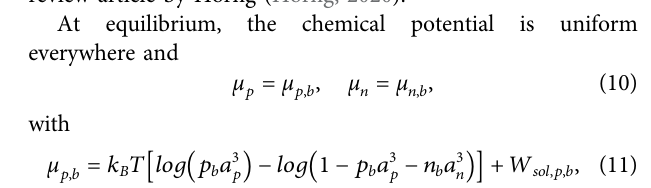
Frontiers in Molecular Biosciences |